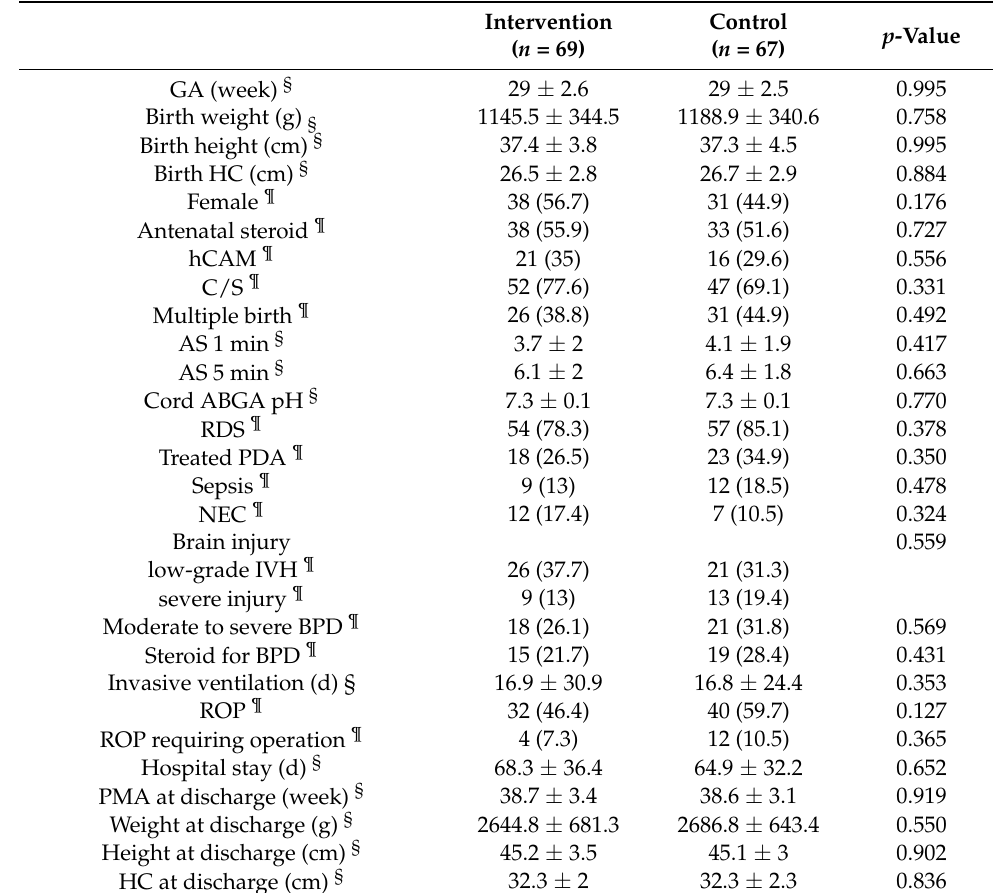
Table 1. Clinical characteristics and outcomes of very preterm babies: intervention vs. control ( n = 136).